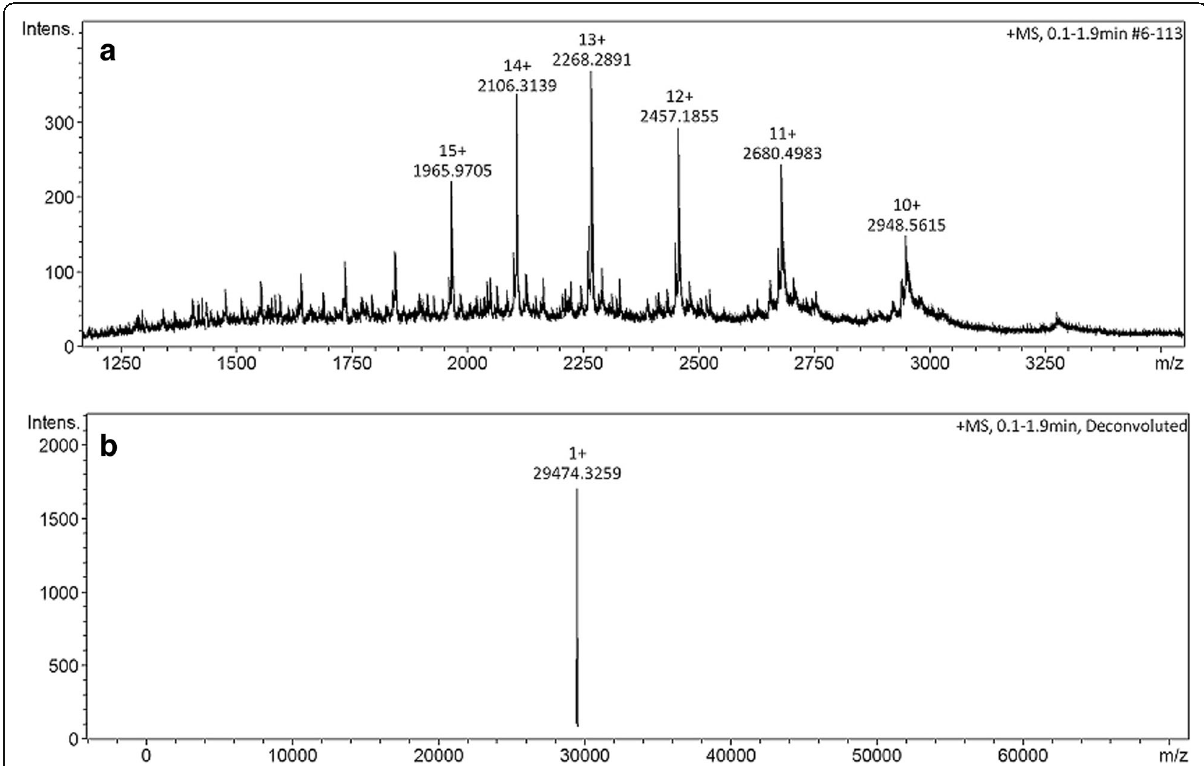
Fig. 7 LC-MS by ESI-ToF mass spectra (MicroQ-ToF III, Bruker Daltonics®). a Different protonated forms of gyroxin from Crotalus durissus terrificus . b Deconvoluted mass spectrum showing [M + H] +1 = 29.472 m/z. Molecular mass of this serine protease is 29.473 Da